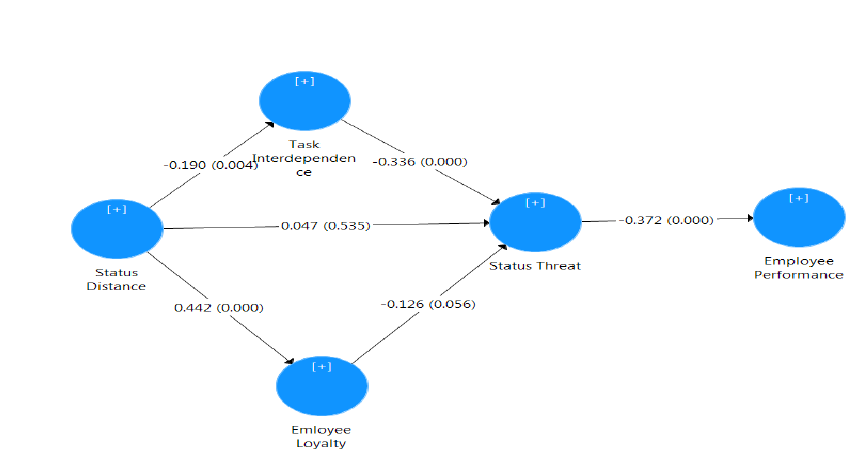
Figure 2: Basic model